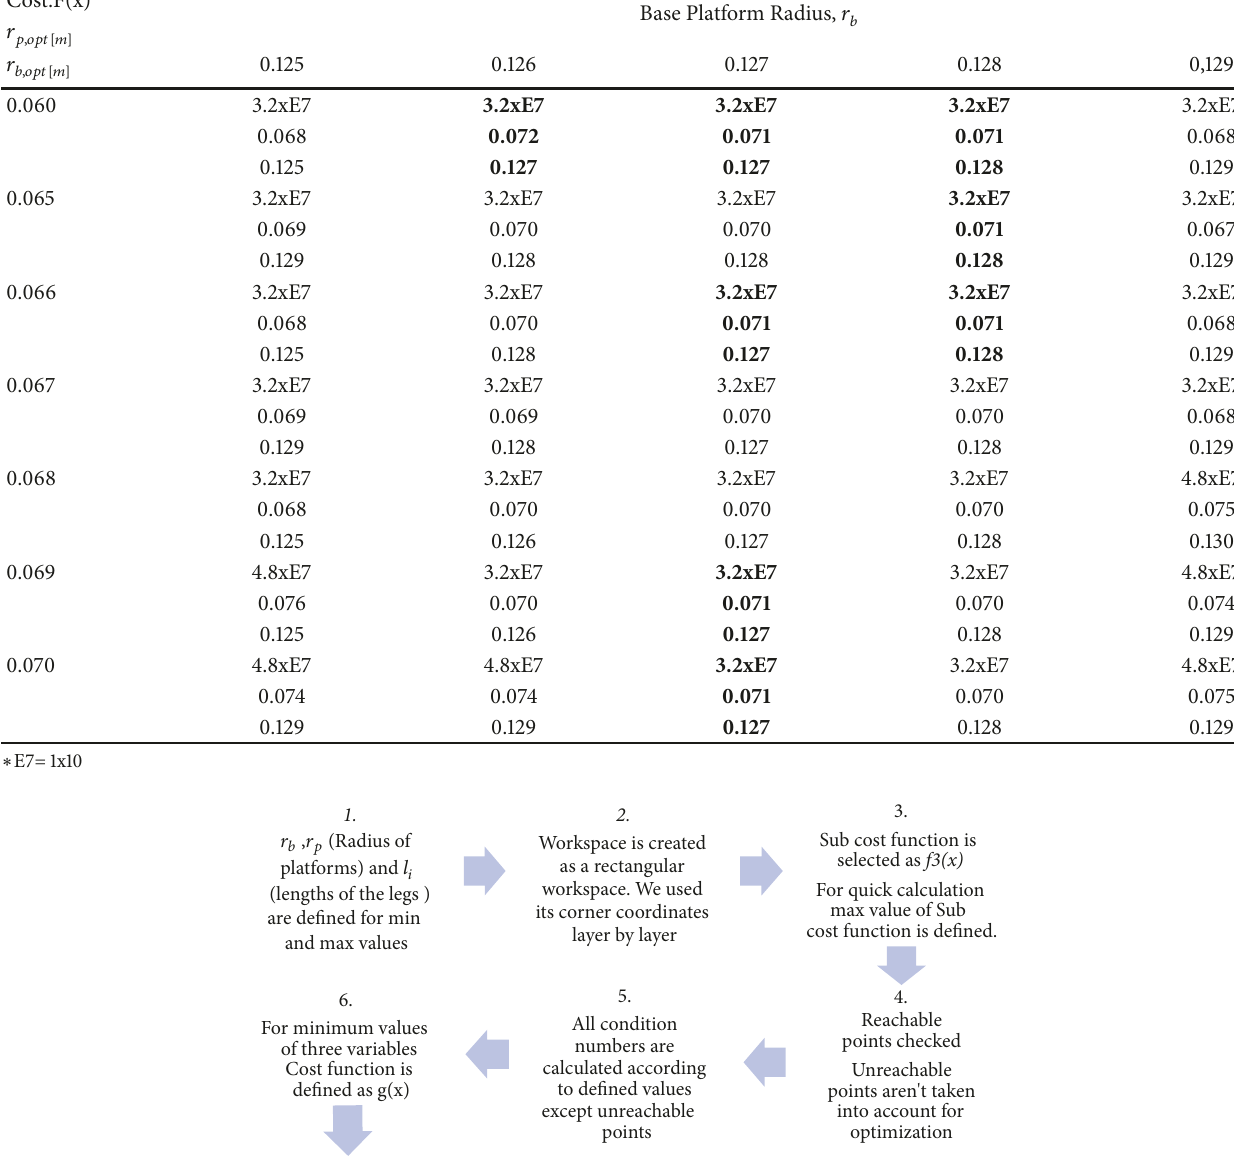
Table 3: Optimization of mobile platform diameter, 𝑟 𝑝 , by narrowing constraint target area.